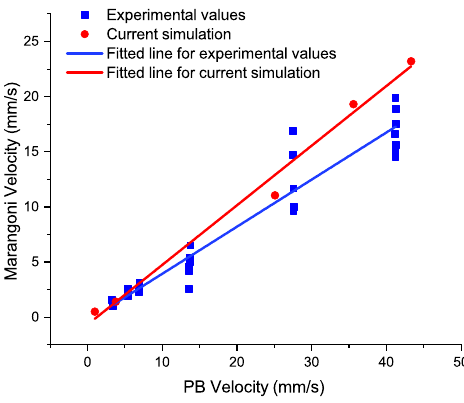
Figure 3. The velocity of the Marangoni flow versus the average velocity of the flow in the channel (PB) [21]. The blue line represents the fitted line for different experimental velocities, which are measured for different film thickness (different flow rates) by Pitois et al. [21]. As shown, our simulation and experiments for the thinner films